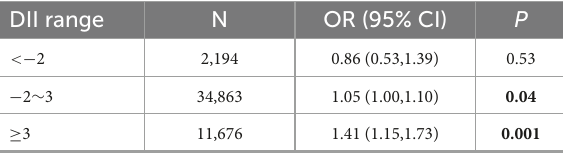
TABLE 3 Threshold effect analysis of the association between dietary inflammatory index (DII) and atherosclerotic cardiovascular disease (ASCVD),